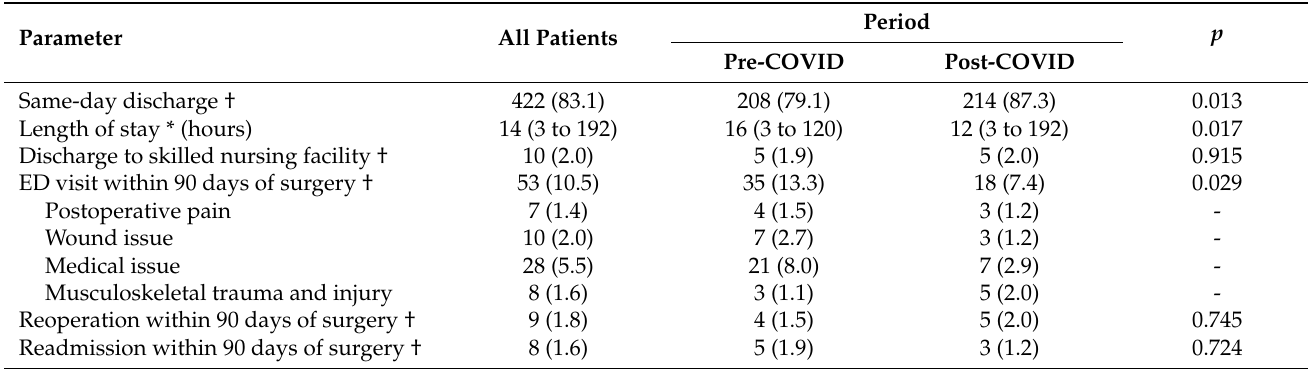
Table 2. Outcomes after total shoulder arthroplasty.